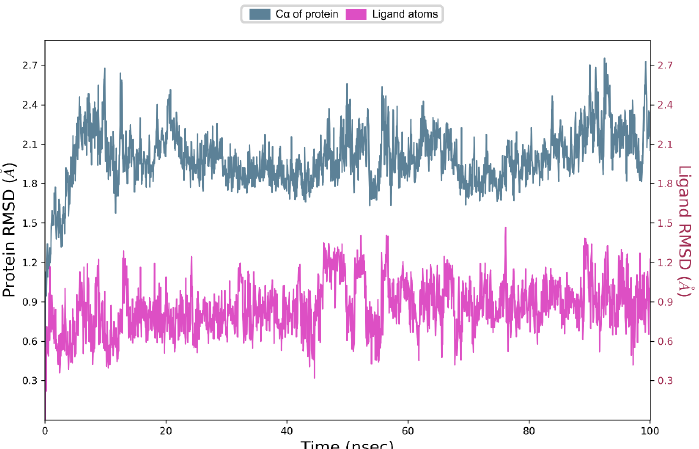
Figure 7. Change in RMSD (root means square deviation) for ligand (pink color) and for C α atoms of tubulin dimer (blue color) during 100 ns of unbiased molecular dynamic simulation. Over the 100 nanoseconds of molecular dynamics, EAPC-67 predominantly formed the non-covalent contacts with the following amino acids B: Leu 248, B: Asn 249, B: Ala 250, B: Asp 251 of the T7 loop, with B: Lys 254, B: Leu 255 of the H8 helix and with B: Lys 352 of the S9 sheet. Therefore, we found that the ligand interacted predominantly with the amino acids of the secondary elements of the T7 loop, H8 helix, and S9 sheet of CBS. The types of non-covalent interactions with these amino acids, including the formation of hy- drogen, hydrophobic, ionic interactions, and the formation of water bridges, as well as the contribution of each interaction type to the overall interaction with a particular amino acid, are shown in the Figures 8A and 9. The time-dependent total number of contacts between the ligand and protein and the number of contacts between the ligand and spe- cific amino acids are shown in Figure 8B.